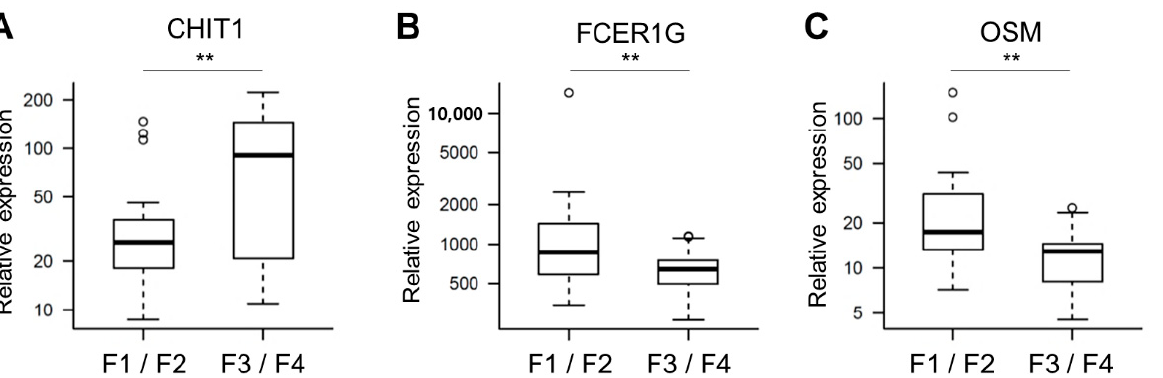
Figure 3. Expression of each gene comprising the gene signature in early stage versus late-stage liver fibrosis. Relative expressions of 5 genes in 24 patients with early-stage fibrosis and in 53 pa- tients with late-stage fibrosis. * p < 0.05; ** p < 0.01. ( A ) CHIT1. ( B ) FCER1G. ( C ) OSM. ( D ) VEGFA. ( E ) ZAP70. Figure 4. Expression of each gene comprising the gene signature in each stage of liver fibrosis in the HBV (( A ), n = 62) and non-HBV (( B ), n = 15) subgroups. 3.3. Factors Associated with Pathological High-Grade Fibrosis Next, univariate and multivariate analyses were performed with the gene signature and clinical parameters in order to identify the factors associated with pathological high- grade fibrosis (Table 3). Gene signature, HBV infection, and platelet count were signifi- cantly associated with high-grade fibrosis in univariate analyses. These three statistically